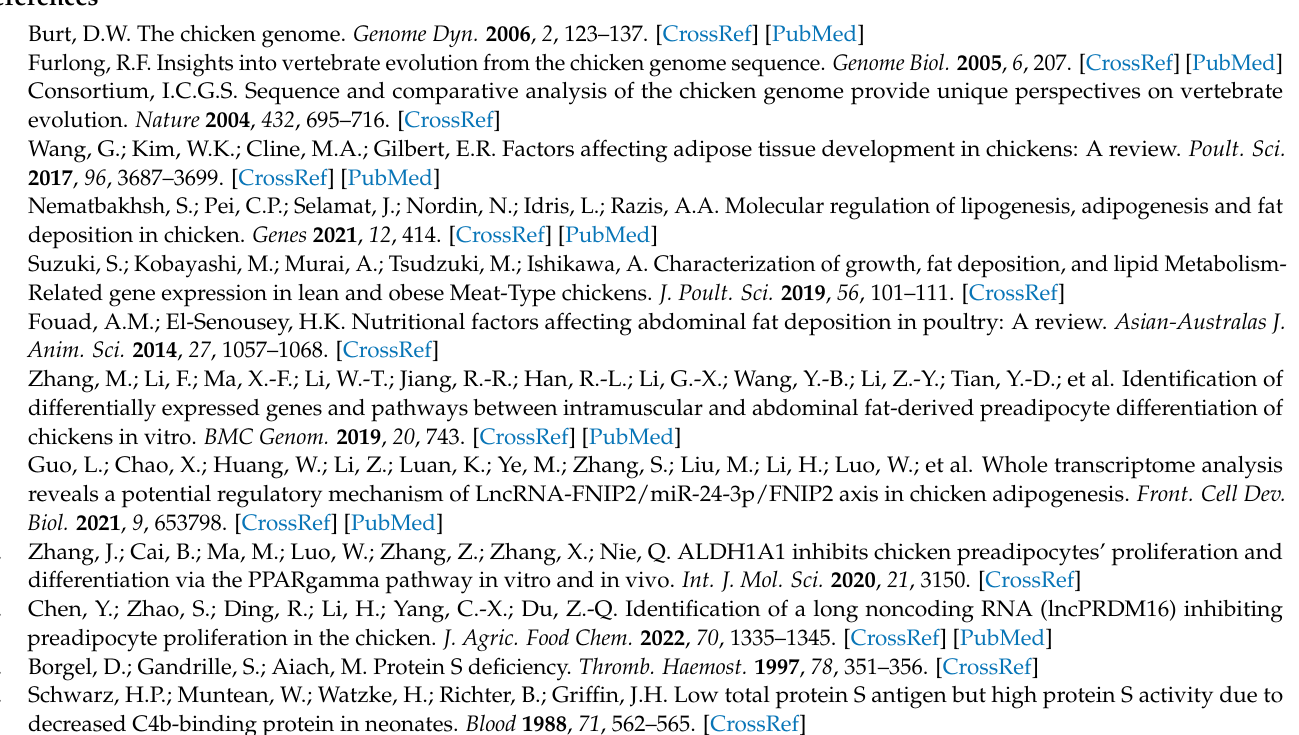
Figure 3D,E; Figure S2: PROS1 5’ flank region DNA polymorphism. The characters on the left represent the genotypes of each SNP. Every SNP site was ringed up by red rectangle; Table S1: Primers’ sequence information; Table S2: Correlation coefficients between carcass